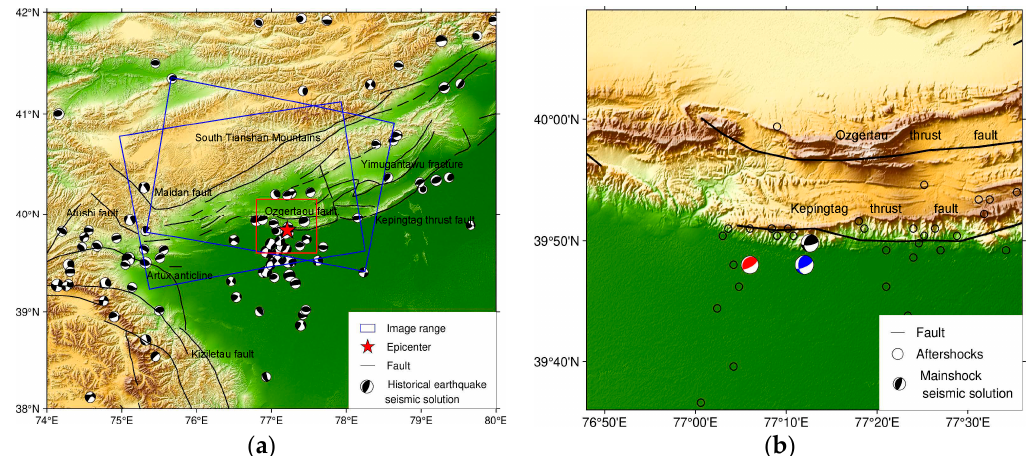
Figure 1. Tectonic background of the 2020 M s 6.4 Jiashi earthquake. ( a ) Regional map showing the location of the earthquake. ( b ) Tectonic setting. The blue rectangles mark the InSAR data coverage; the black beach balls denote the M s > 3 earthquakes that occurred in the area from 1965 to 2020; the red star denotes the epicentre; the red rectangle outlines the area shown in ( b ). The red, black, and blue beach balls show the focal moment solutions reported by the USGS, Global Centroid Moment Tensor (GCMT), and CENC, respectively, which are shown in ( b ). The black dots represent the aftershocks ( M s > 3) that occurred between 19 and 26 January 2020, reported by the GCMT. The black lines depict the major strike fault, Keping fault, and Ozgertaou fault.